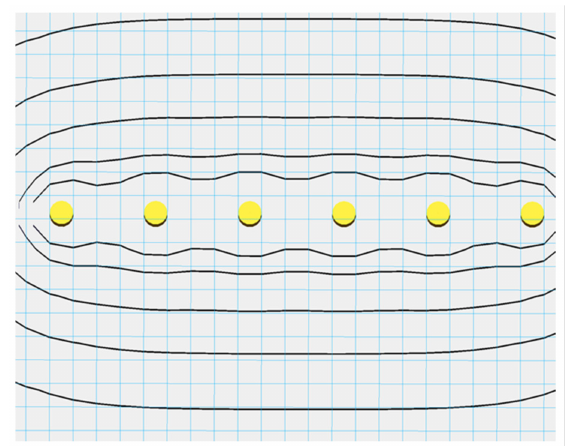
Figure 4. Pressure Iso-Line for Multiple Number of Source Points in Parallel.